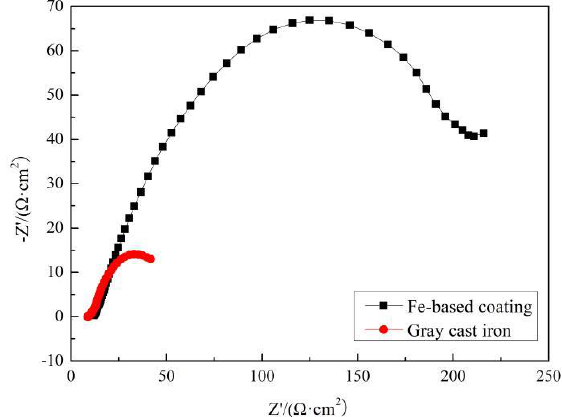
Figure 11. Nyquist diagram of Fe-based coating and HT300 in 3.5% NaCl solution.